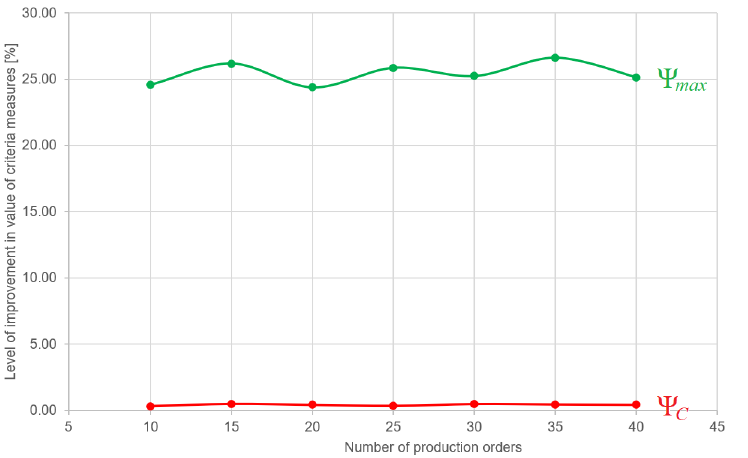
Figure 10. Th effect of taking into account the influence of resources for the production of the RG